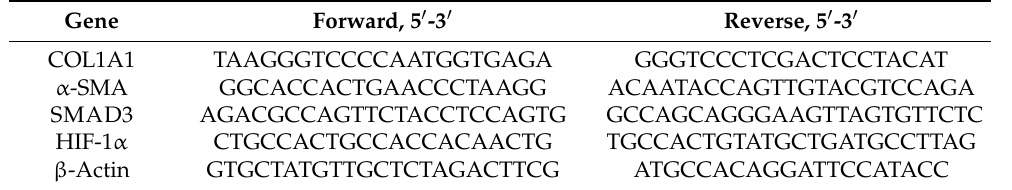
Table 1. Sequences of the